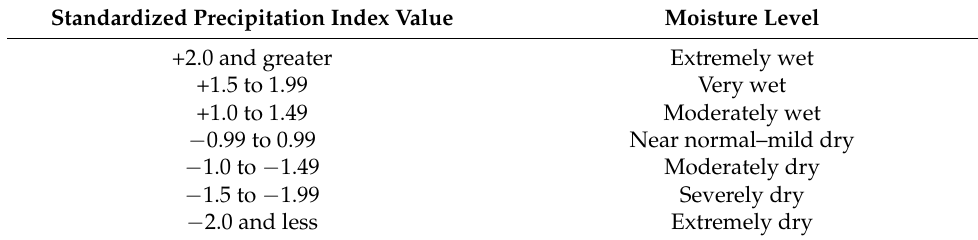
Table 3. Standardized Precipitation Index classification